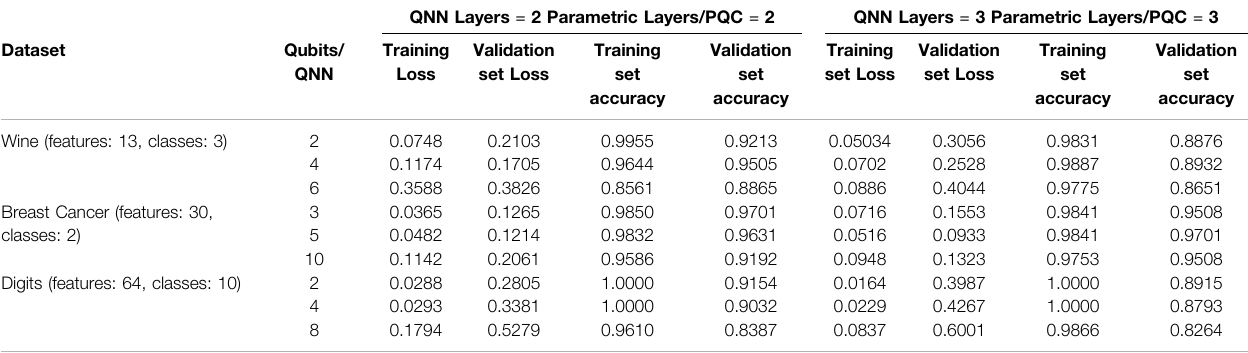
TABLE 1 | QNet performanceafter 20 epochs of training on Wine, Breast Cancer, and Digits classi fi cation datasets with varying QQ, QL, and PL. QNet performs better with lower QQ. Larger networks tend to over fi t, e.g., training performance improves from QL (cid:2) 2, PL (cid:2) 2 to QL (cid:2) 3, PL (cid:2) 3 while validation performance falls down.